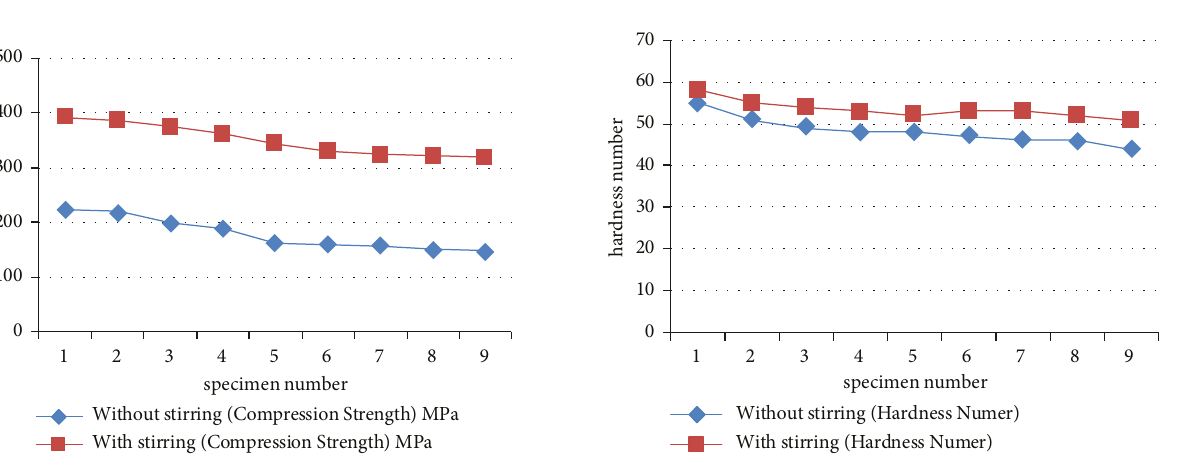
Figure 27: Graph for hardness number compared with stirring and without